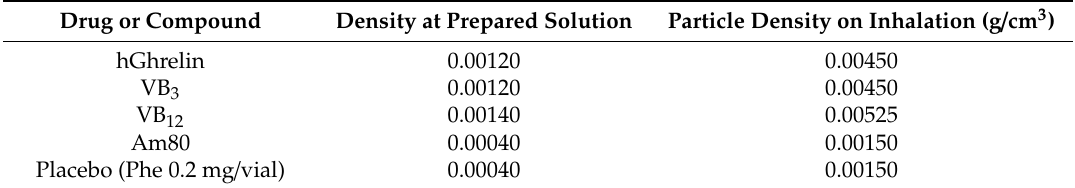
Table 2. Particle density calculated by conversion factor